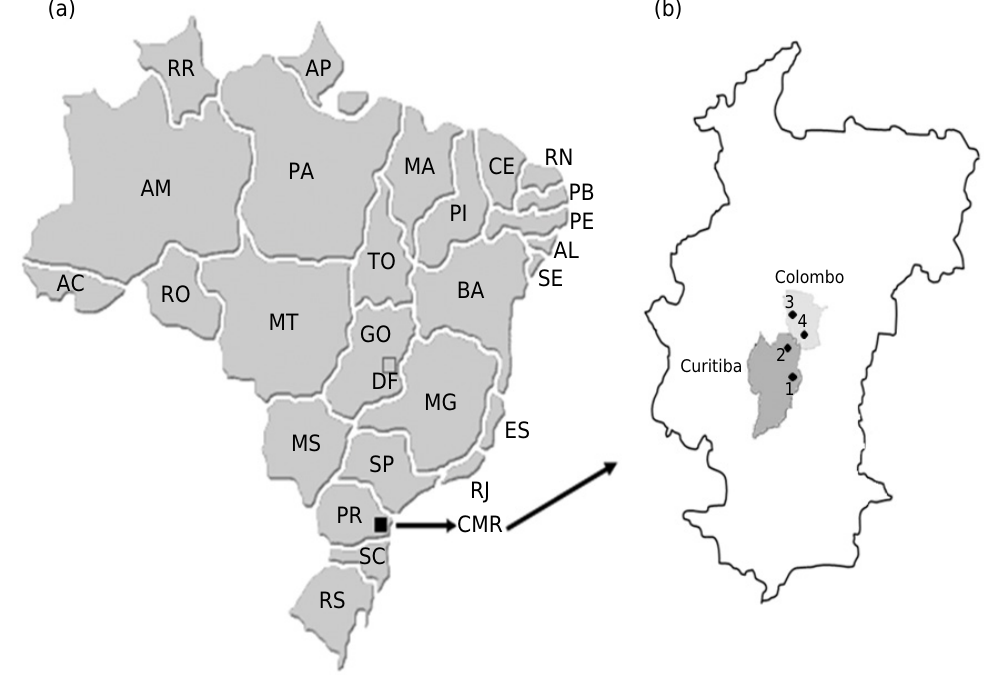
Figure 1. Map of Brazil highlighting the Paraná State (PR) (a) and the Curitiba Metropolitan Region (CMR), and Curitiba (1-Boa Vista and 2-Santa Candida) and Colombo (3-Guaraituba and 4-Guarani) (b).